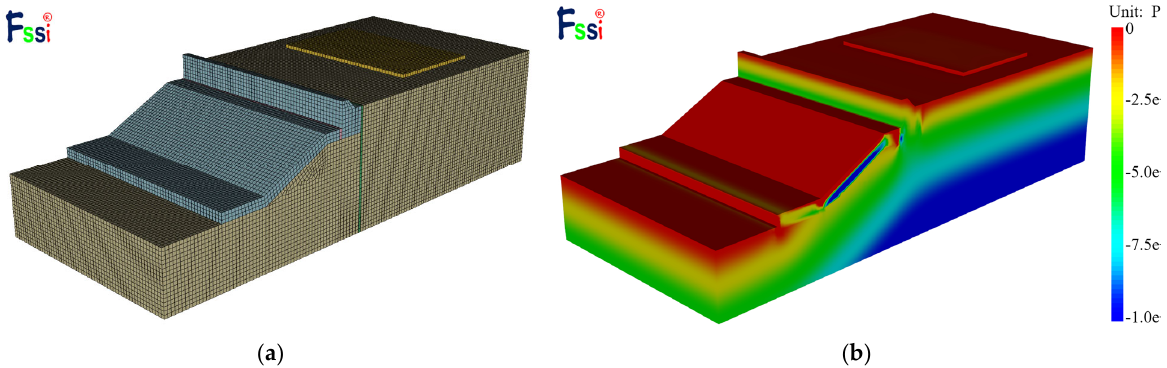
Figure 12. Finite element mesh discretization and initial vertical effective stress distribution. ( a ) Finite element mesh. ( b ) Vertical effective stress.